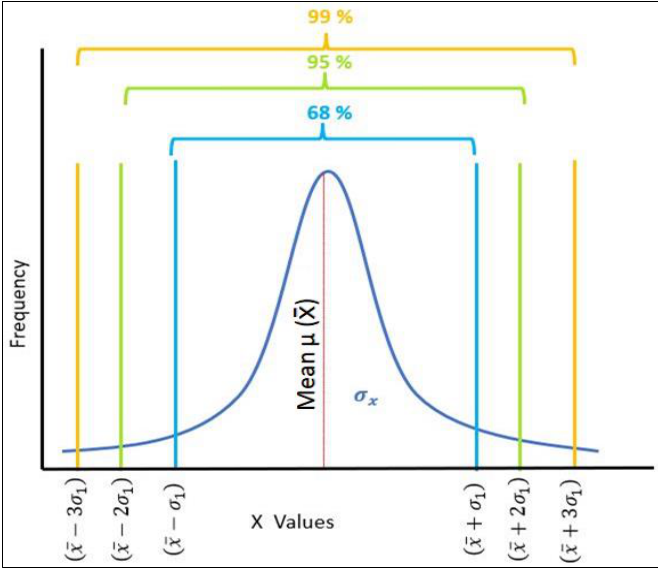
Figure 3: Probabilities in the normal distribution. 99%, 95% y